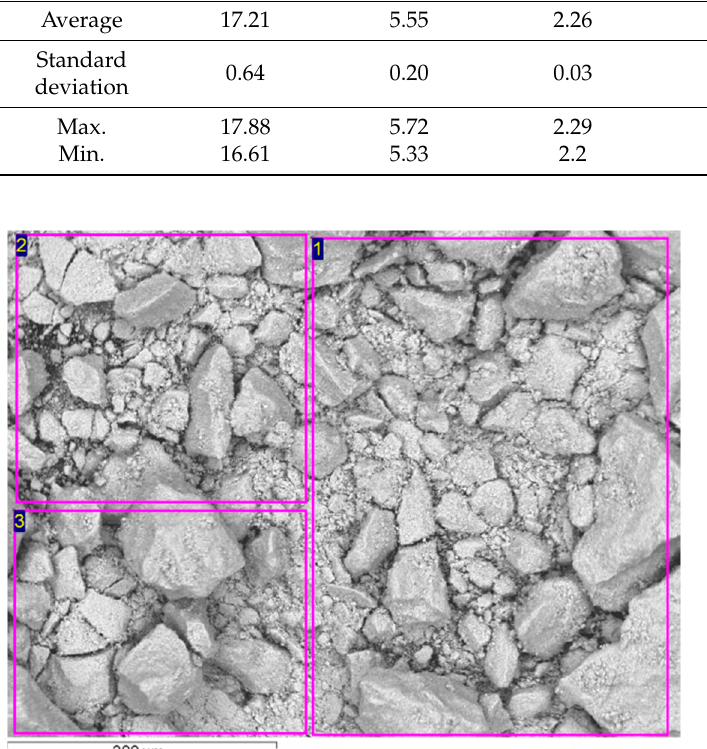
Figure 2. A micrograph of the catalyst sample. The selected areas (1–3) on the surface of the catalyst were used to determine the composition by the EDX method and correspond to spectra 1–3 in Table 1. Table 1. The elemental composition of the catalysts obtained by the EDX method (at. %).